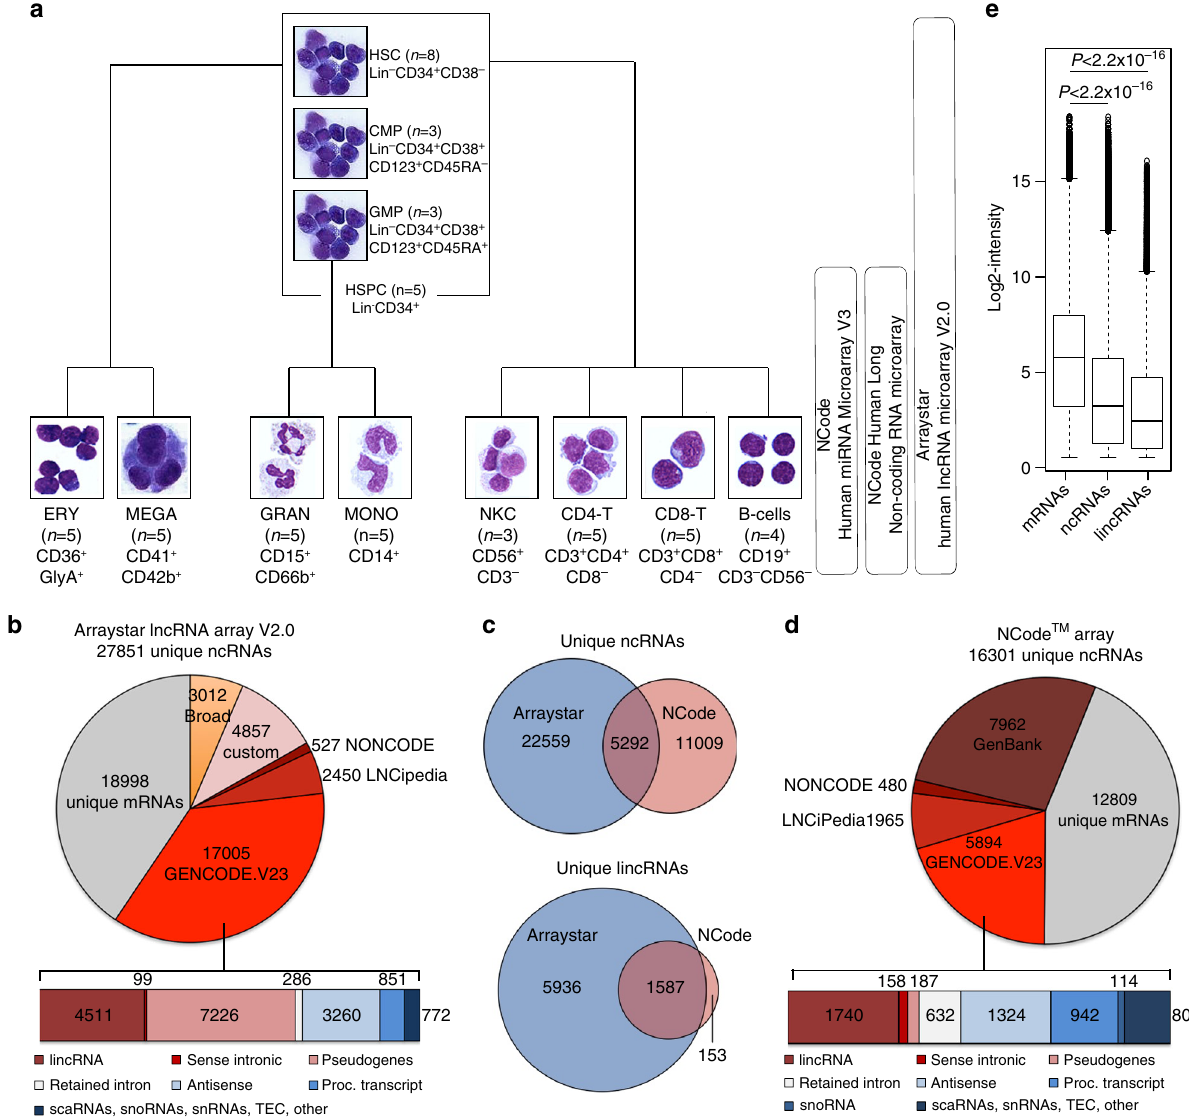
Fig. 1 Microarray-based pro fi ling of the ncRNA landscape in normal hematopoiesis. a Blood cell populations puri fi ed by multicolor fl ow cytometry from different healthy individuals: hematopoietic stem cells ( HSCs ), common myeloid progenitor cells ( CMPs ), granulocyte-monocyte progenitor cells ( GMPs ), megakaryocytes ( MEGA ), erythroid precursors ( ERY ), granulocytes ( GRAN ), monocytes ( MONO ), CD4 and CD8 T-cells, NK cells ( NKC ), and B-cells. Cytospins were prepared after sorting. For HSCs, CMPs, and GMPs representative cytospins from in vitro expanded CB HSPCs are depicted. b Annotation, distribution, and functional classes of the Arraystar Human lncRNA Microarray V2.0 probes according to the indicated databases. c Overlapping features between the Arraystar Human lncRNA Microarray V2.0 and the NCode Human Long Non-coding RNA microarray. d Annotation, distribution, and functional classes of the NCode Human Long Non-coding RNA microarray probes. e Box plots of log 2 -probe intensities for mRNAs ( n = 978,840), ncRNAs ( n = 784,530), and lincRNAs ( n = 90,855) from all NCode Human Long Non-coding RNA microarrays. P -values were calculated using the